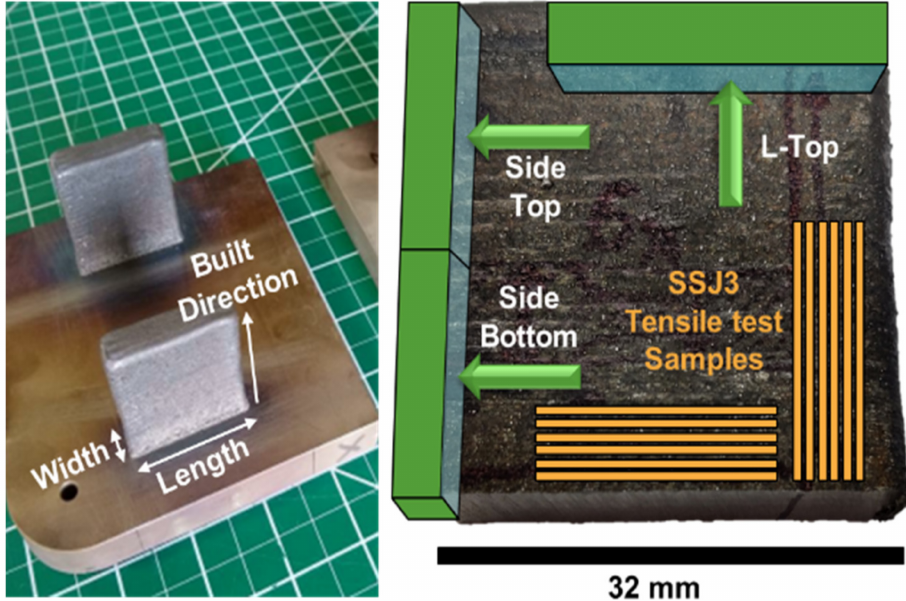
Figure 1. Locations where tensile test samples were extracted and three locations labeled “Side Bottom”, “Side Top” and “L-Top”, where microstructures were